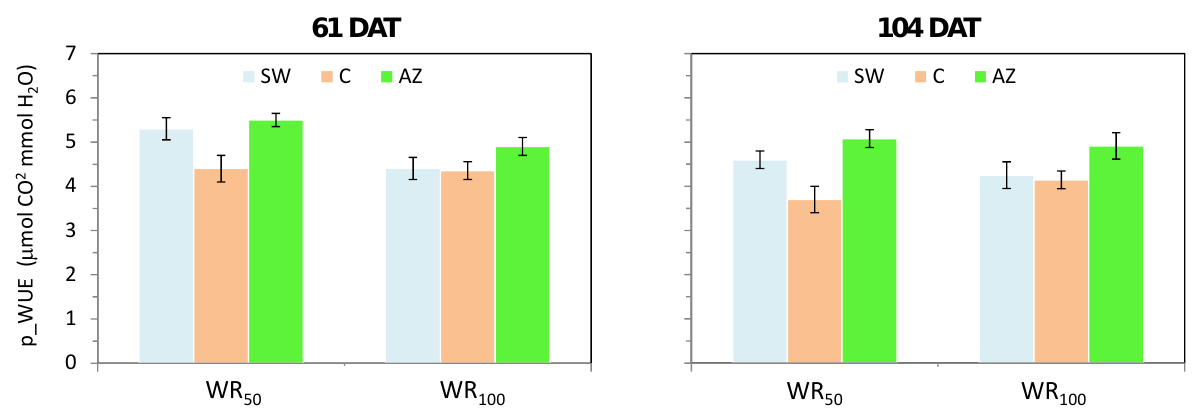
Figure 2. Interaction between water regime and treatments with biostimulants on the photosyn- thetic water use efficiency (p_WUE) of wild rocket 61 and 104 days after transplantation (DAT). WR 100 = restoration of 100% of ETc; WR 50 = restoration of 50% of ETc; C = control; AZ = application of azoxystrobin; SW = application of a seaweed extract-based biostimulant. The vertical bars indicate the standard deviation.